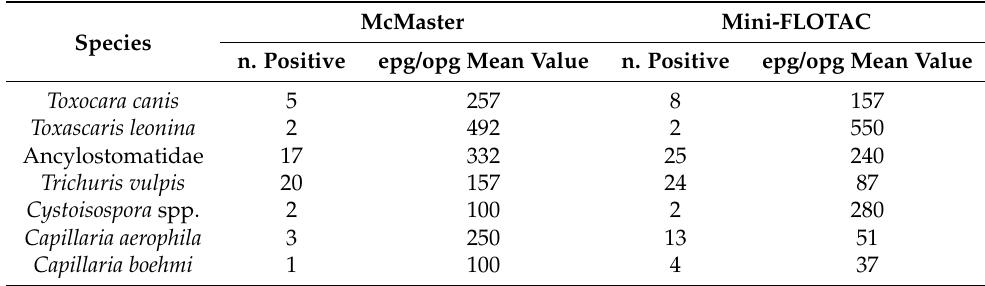
Table 3. Number (n) of canine positive samples detected using quantitative techniques and mean value of epg (eggs per gram of feces) or opg (oocysts per gram of feces) retrieved for each parasite.